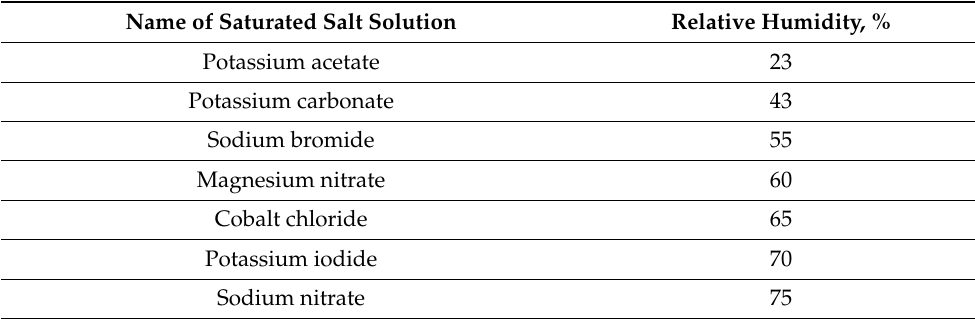
Table 2. Identification of saturated salt solutions used to generate different values of humidity levels at 25 ◦ C. Name of Saturated Salt